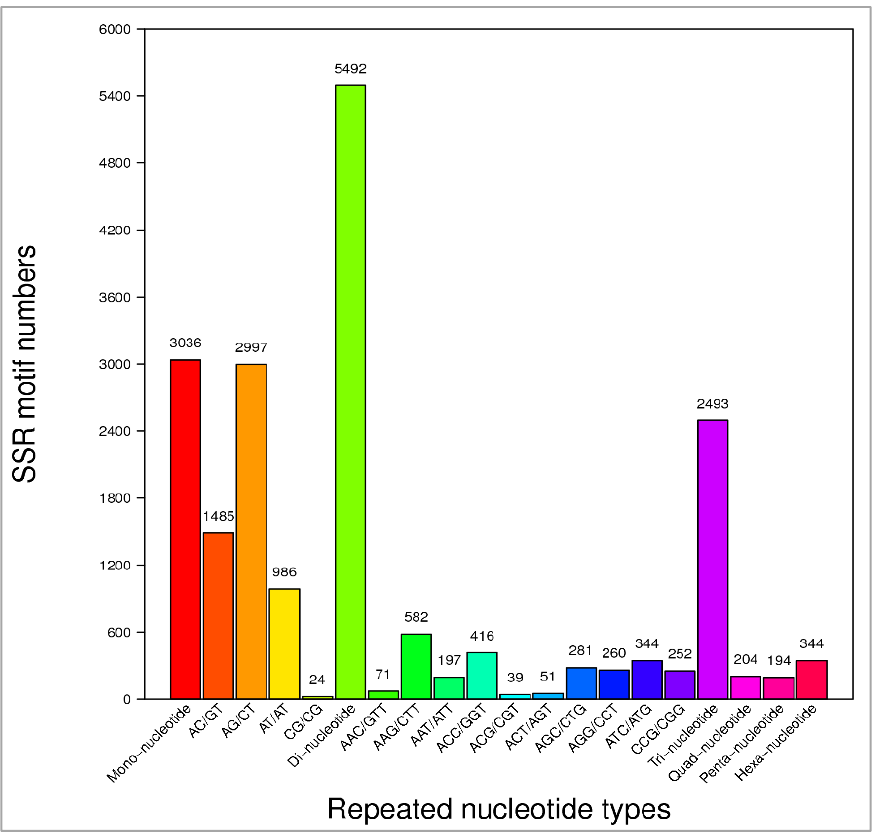
Figure 7. Simple sequence repeat (SSR) marker variation statistics. Number of motifs are given against each repeated nucleotide category from mono-nucleotides to hexa-nucleotides.